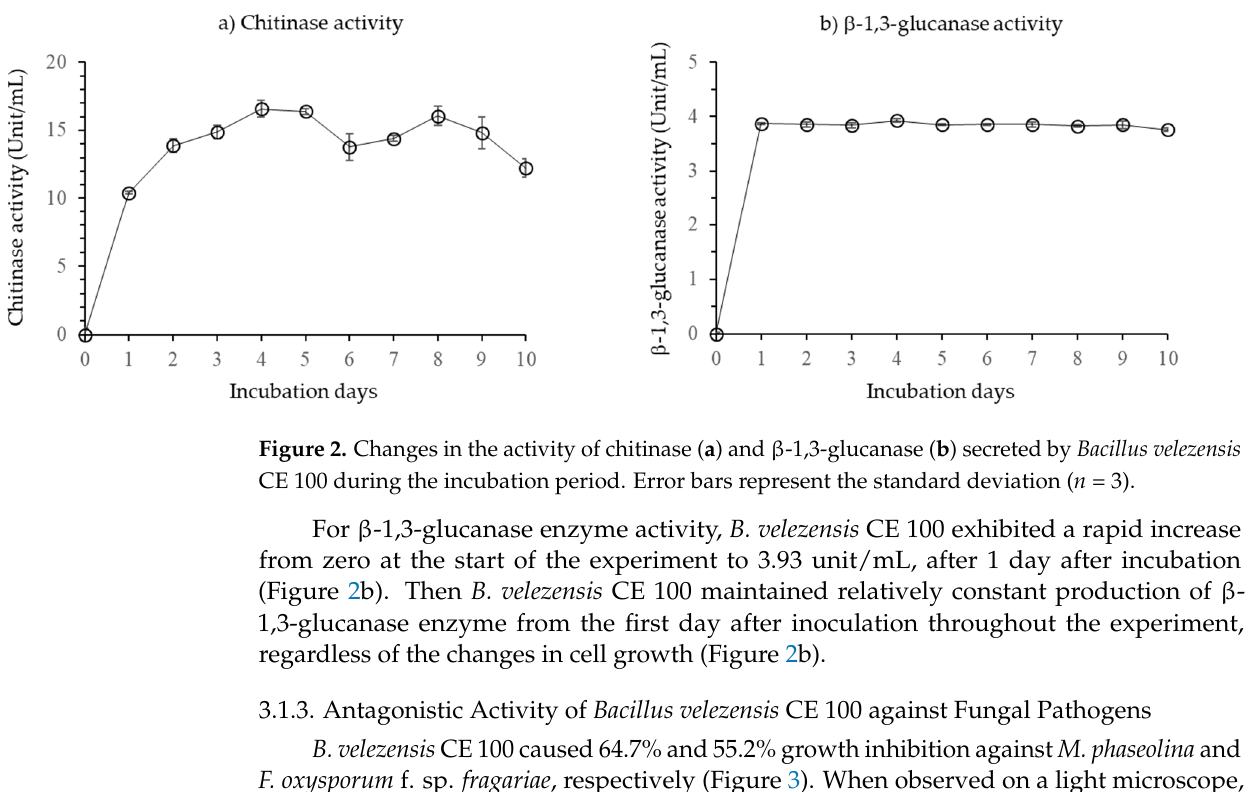
Figure 3. Inhibition of the mycelial growth Macrophomina phaseolina and Fusarium oxysporum f. sp. fragariae by Bacillus velezensis CE 100 ( a ) and antagonistic activity of B. velezensis CE 100 against M. phaseolina and F. oxysporum f. sp. fragariae ( b ), using the dual culture method on PDA medium. Error bars represent the standard deviation ( n = 3).